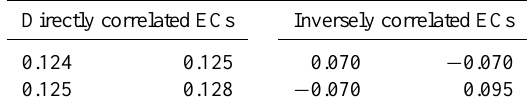
Table A1. Covariance matrix, left: case 1; right: case 2. Directly correlated ECs